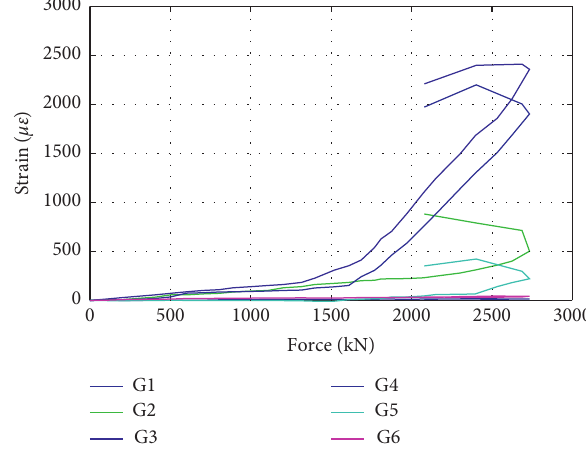
Figure 15: Strain diagram of stirrups.